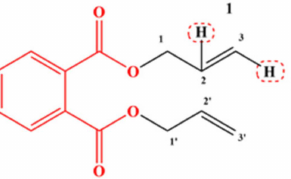
Figure 2. Site map of the molecular modification of